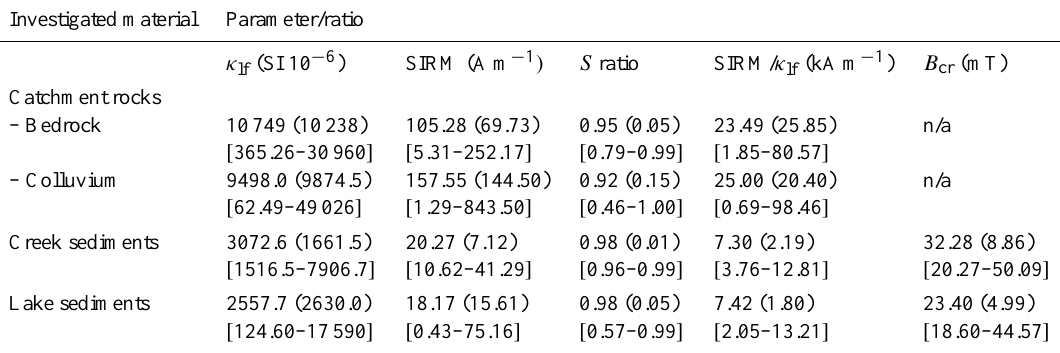
Table 3. Selected magnetic parameters from catchment rocks, creek sediments and lake sediments. Mean value, (standard deviation) and [total range of values] are shown. See text for